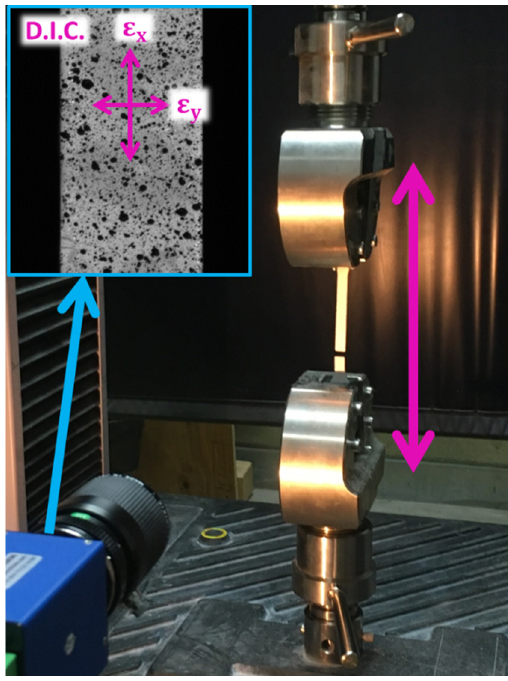
Figure 2. Testing apparatus.